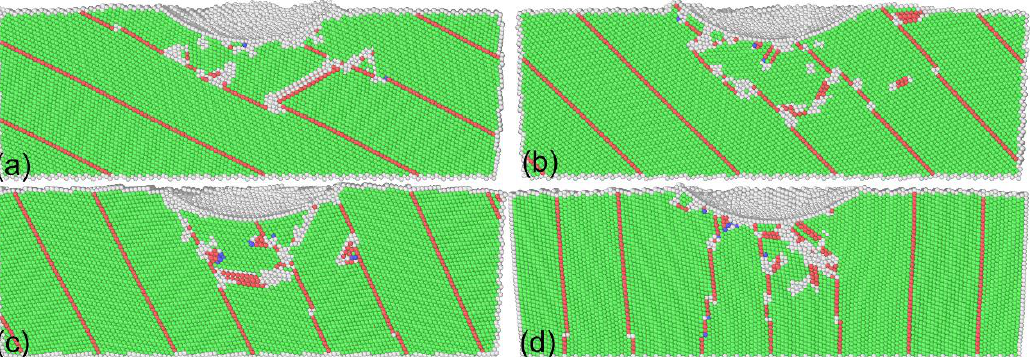
Figure 6. Cross-sectional views of twinned Al with different inclination angles after nanoindentation. Inclination angle: ( a ) 26°; ( b ) 45°; ( c ) 64°; and ( d ) 90°. Atoms are colored according to their CNA values.